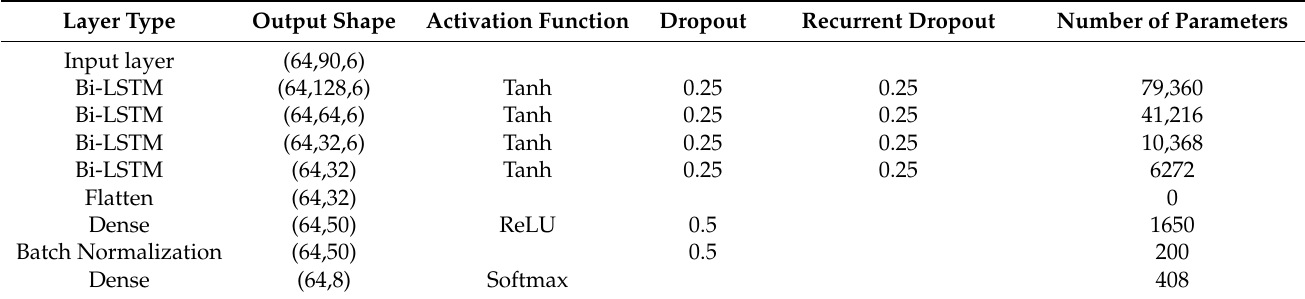
Table 2. Network architecture and tuning.